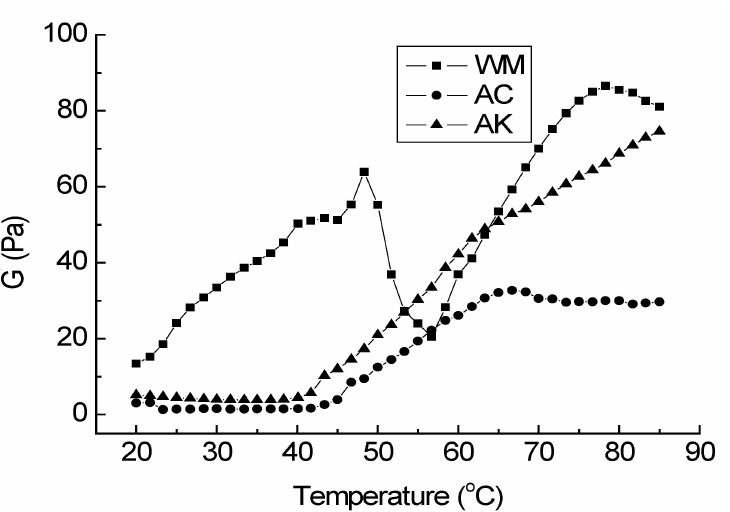
Figure 1. Rheology of surimi and isolated proteins. WM: water-washed surimi, AC: acid-isolated protein, AK: alkali-isolated